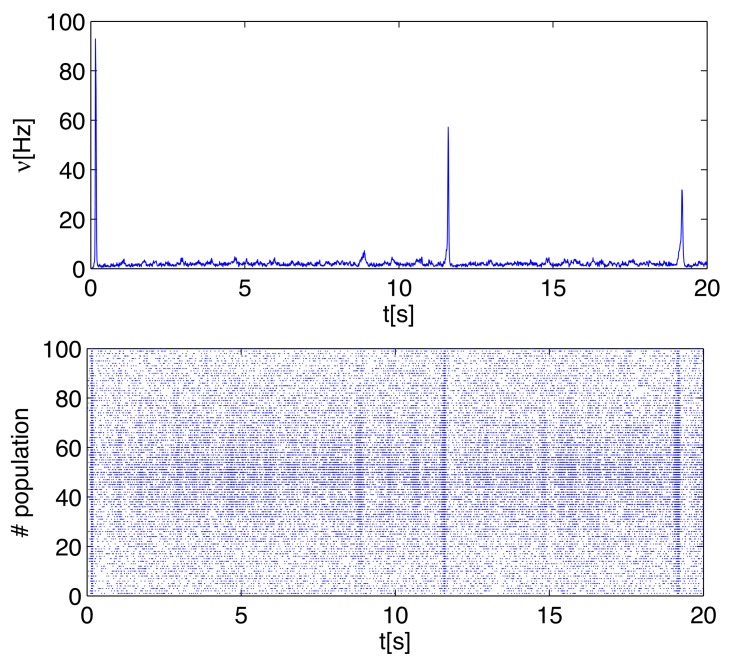
Illustrative time course of neuronal activity in a bursting network with spatially non-uniform synaptic connectivity and synaptic short-term depression (see text for details).Top panel: sample time course of the average firing rate. Bottom panel: raster plot from a sub-set of 100 neurons, corresponding to the time record of the top panel. The network comprises N = 1000 excitatory neurons (J
ij are drawn from a Gaussian distribution with mean 0.846 mV and standard deviation of 0.211 mV), δ
ij exponentially distributed from 1 ms to 15 ms, and synapses are endowed with short-term depression with recovery time τ
r = 800 ms and synaptic release fraction u = 0.2 (see Methods for details); the external current is a train of Poisson spikes with average rate ν
ext = 0.6 kHz, and synaptic efficacy randomly sampled from a Gaussian distribution of mean J
ext = 0.9 mV and standard deviation 0.225 mV.